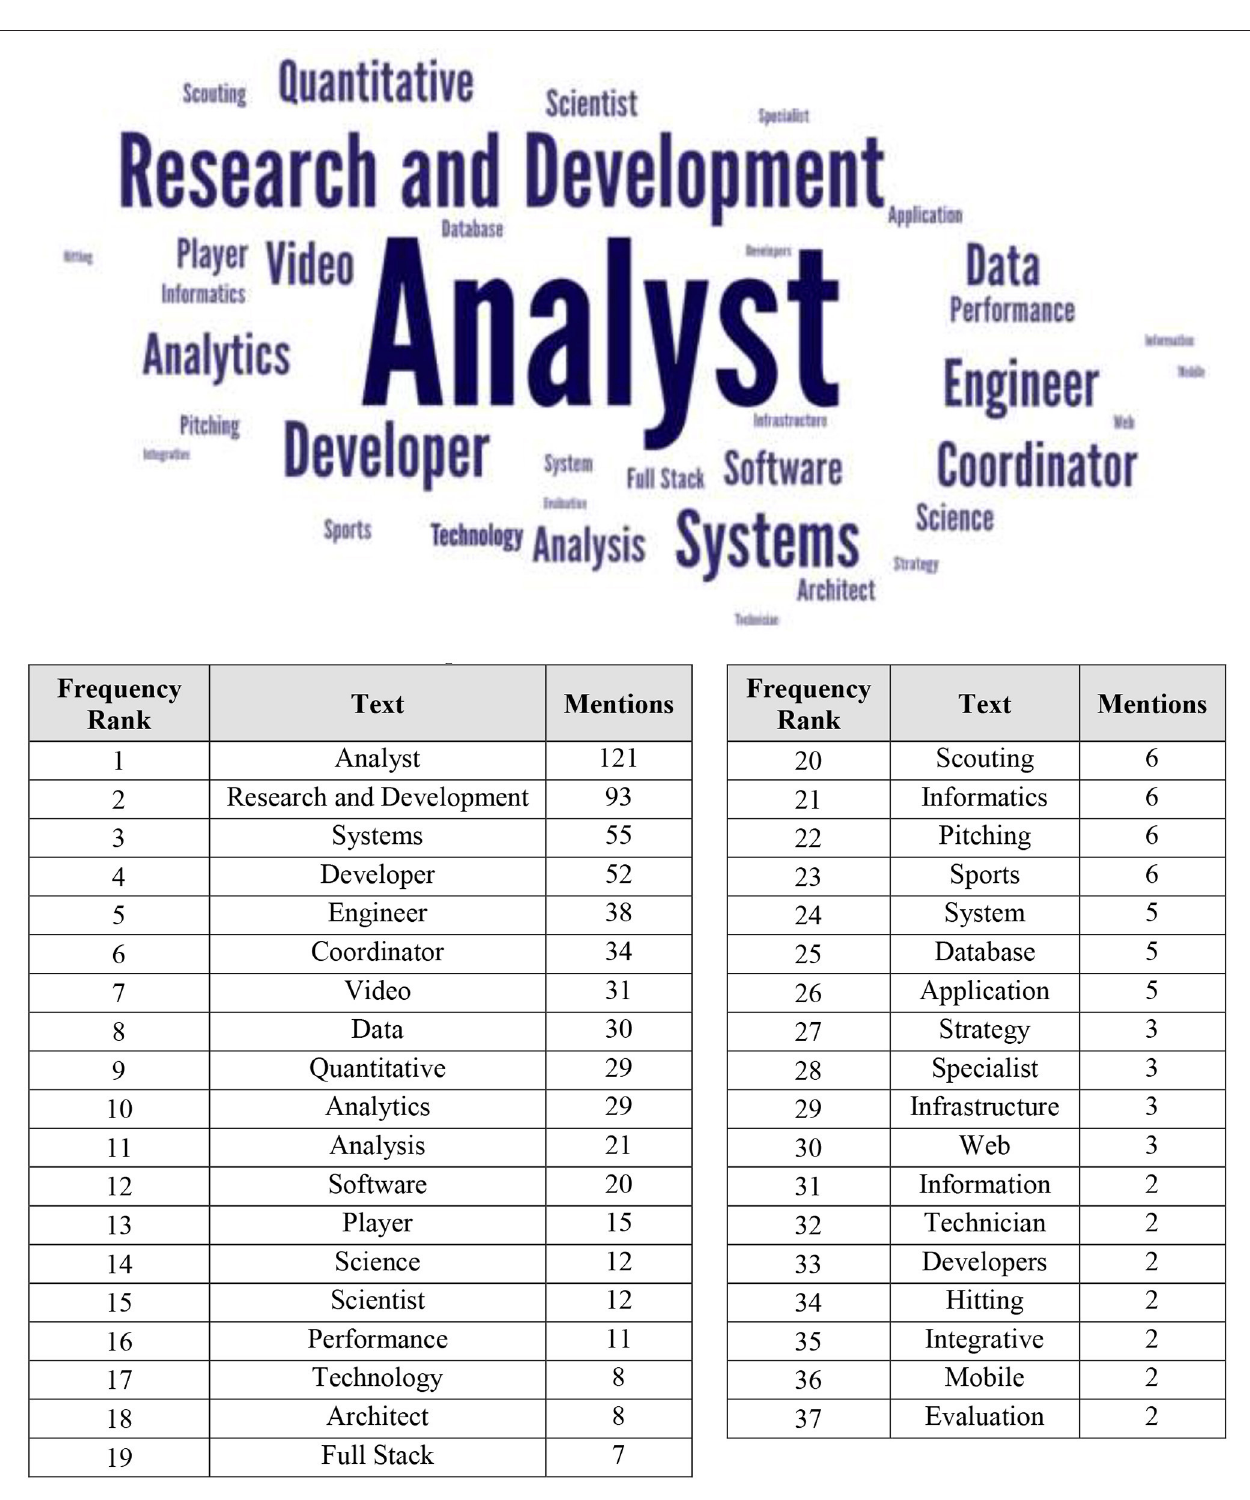
Frontiers in Sports and Active Living |